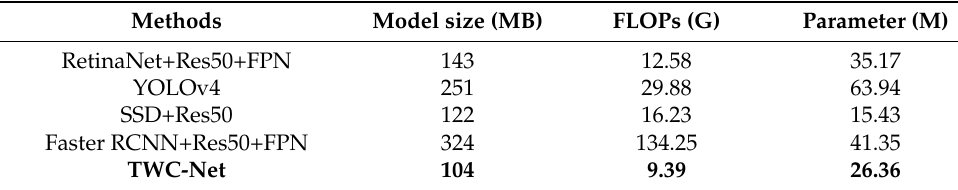
Table 5. Model size, FLOPs, and number of parameters of all methods.